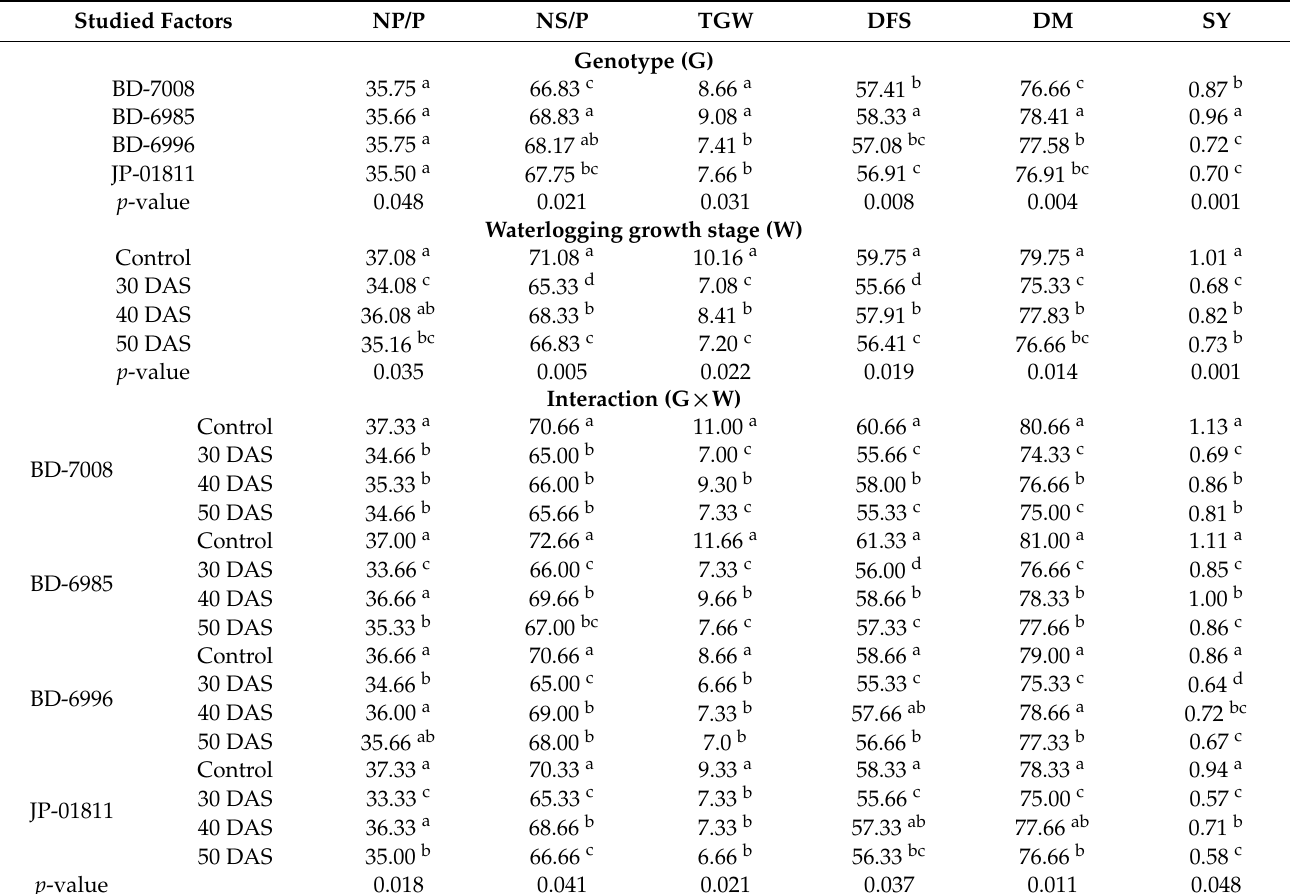
Table 7. Yield-contributing traits of sesame genotypes as influenced by waterlogging stress at different growth stages. Studied